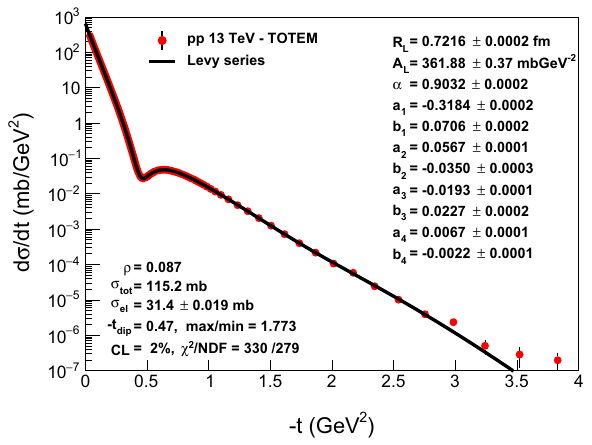
Fig. 1 Equation (1) fitted to the recent LHC TOTEM d σ/ dt data at √ s = 13 TeV